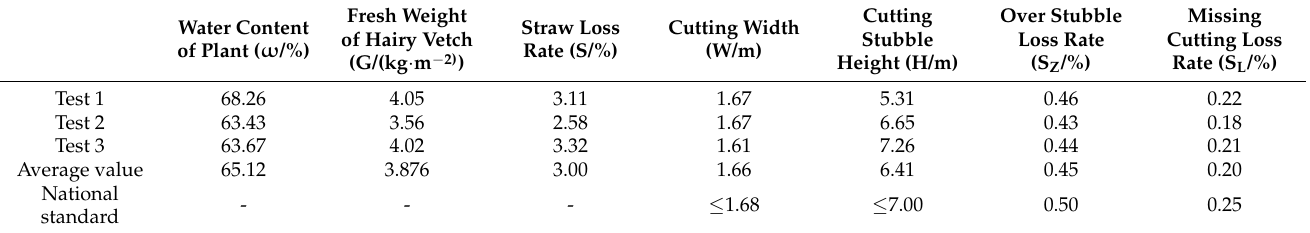
Table 7. Field performance test